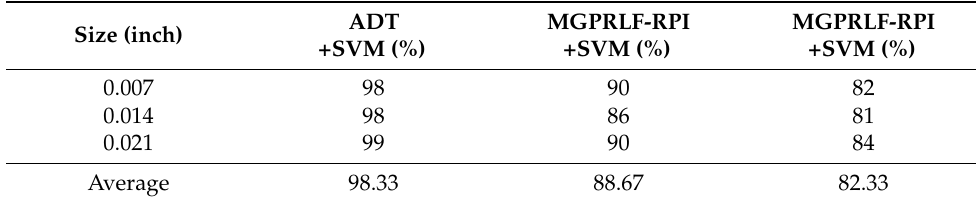
Table 7. The average accuracies of the inner crack size identification using the ADT+SVM, MGPRLF- RPI+SVM, and MGPRLF-PI+SVM techniques.